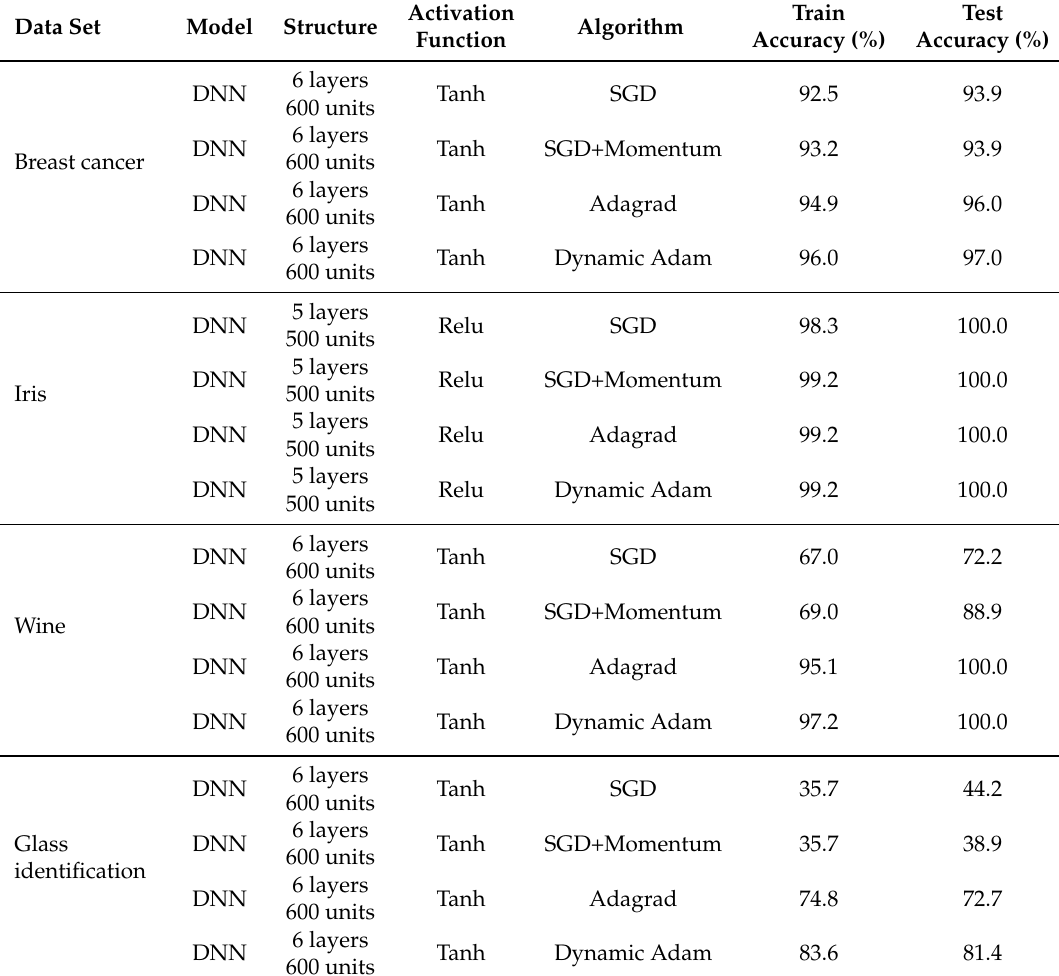
Table 5. Analysis results of model performance with standard